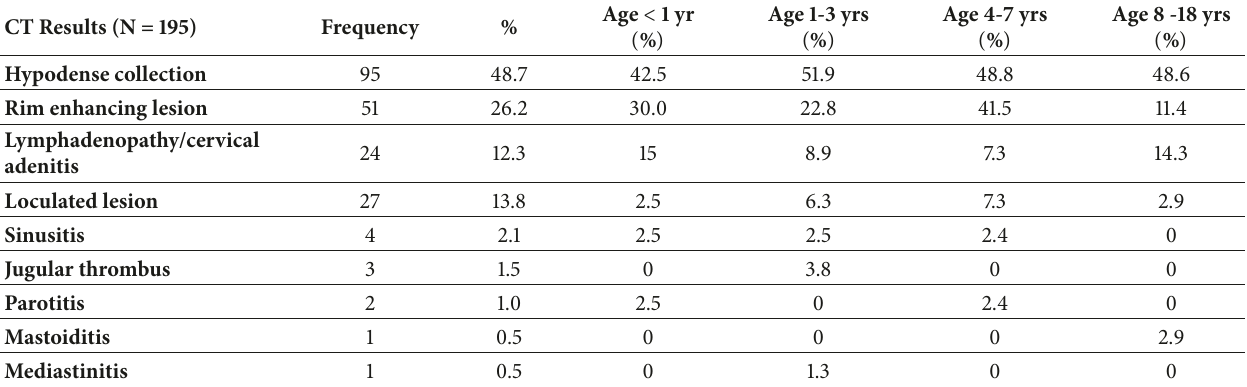
Table 5: Findings for computed tomography (CT) scan. 43 patients had multiple